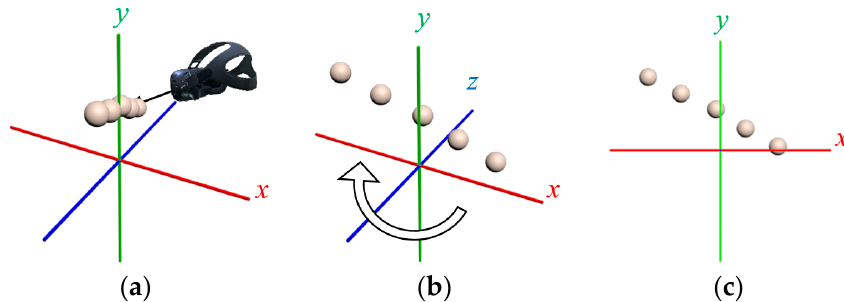
Figure 2. Schematic diagram of 2D mapping. ( a ) the relationship between the original data and the helmet, ( b ) remove the helmet rotation and position status and ( c ) results of removing z-axis information.